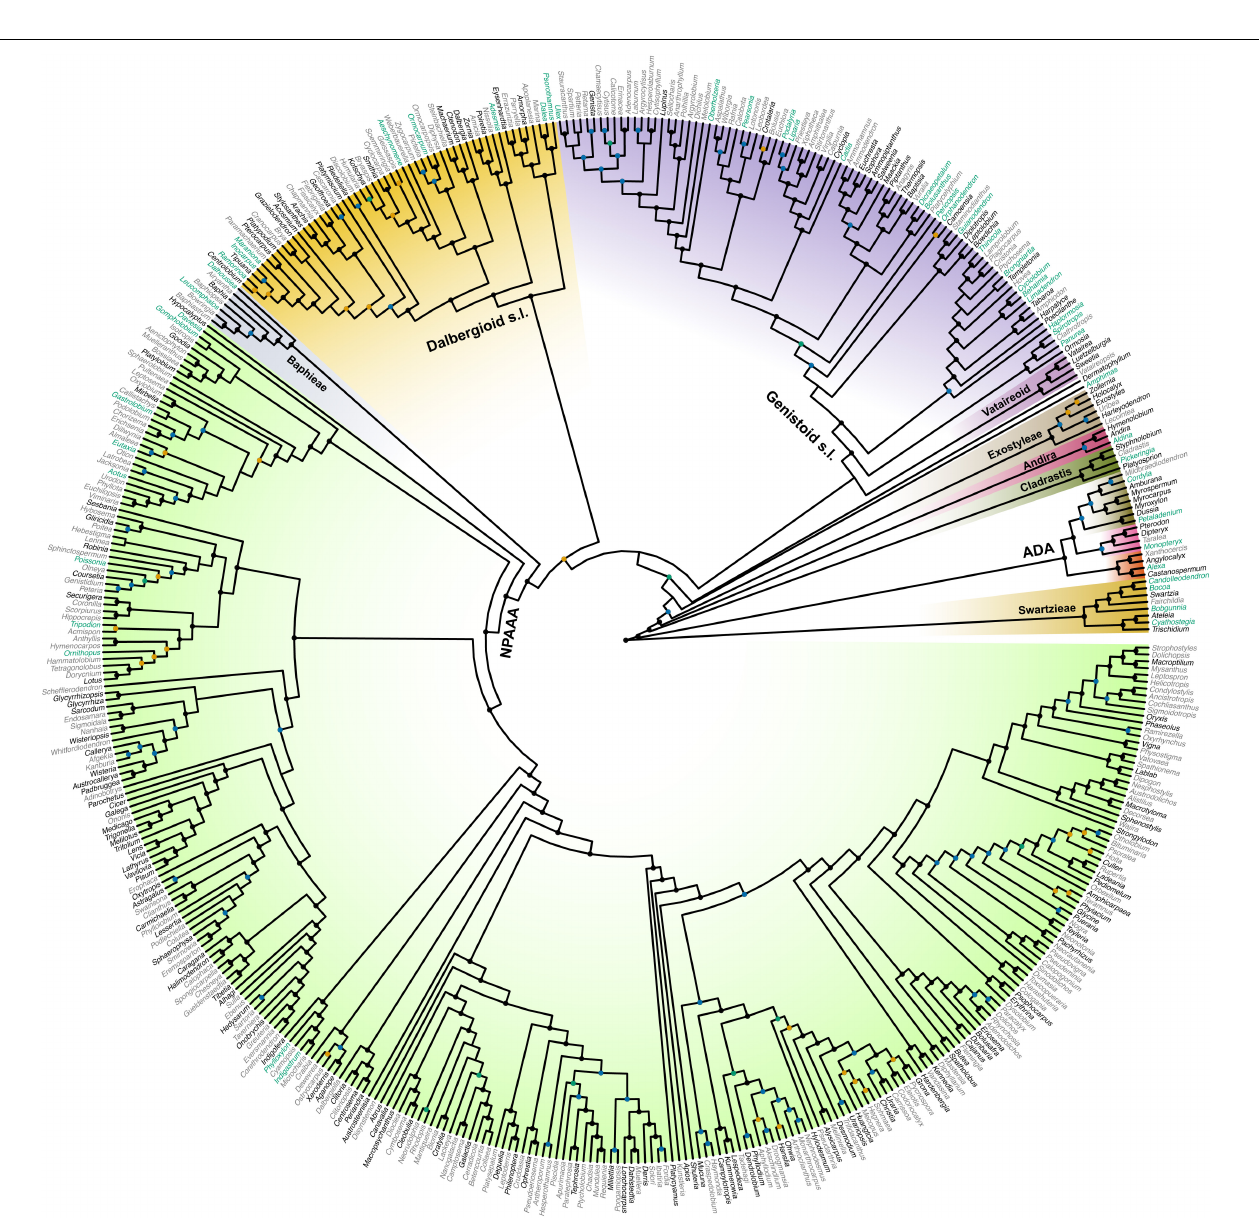
FIGURE 6 | A genus-level phylogeny of Papilionoideae as produced by the maximum likelihood analysis of the dataset 9 (CD_matK_cb), which combined genera with fully sequenced plastomes and the expanded sampling of genera with matK sequence data only. Black nodes are supported by bootstrap values (BS) = 100 and blue nodes by BS = 90–99, while orange nodes are supported by BS = 80–89 and cyan nodes by BS = 70–79. Genera highlighted in black have already been fully sequenced for plastomes. The 50 genera highlighted in cyan are either still phylogenetically enigmatic, are morphological key genera, or represent monospecific lineages, all of which should be the focus of future plastome research. The colors for clades are not related to their support values. We followed the color scheme for papilionoid clades of Figure 1 in Cardoso et al. (2013a). NPAAA: non-proteinogenic amino acid accumulating, ADA: Angylocalyceae, Dipterygeae, and Amburaneae.